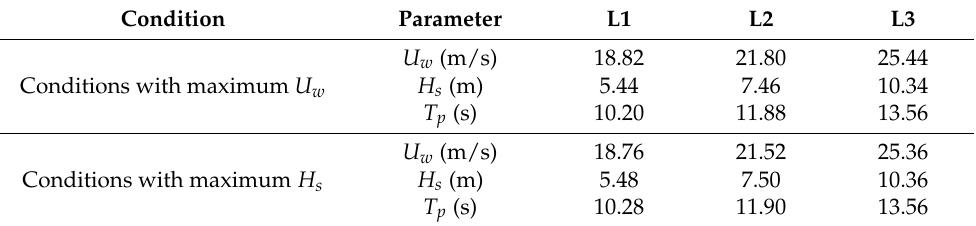
Table 5. Environmental conditions on the 50-year contour surfaces with maximum U w or maximum H s .